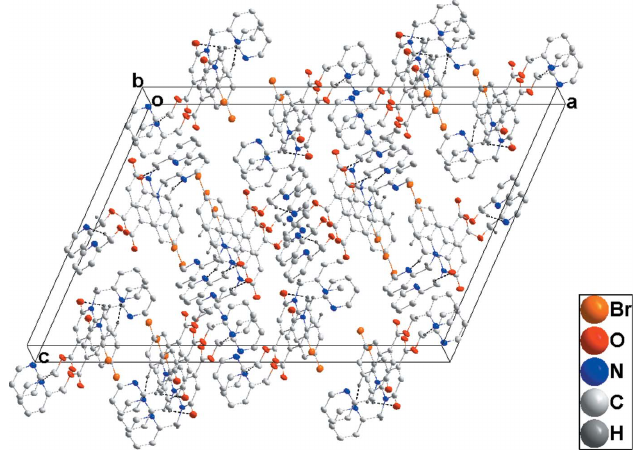
Figure 3 Packing projected along the b -axis direction with C—H (cid:3)(cid:3)(cid:3) O and C— H (cid:3)(cid:3)(cid:3) N hydrogen bonds shown as black dashed lines.